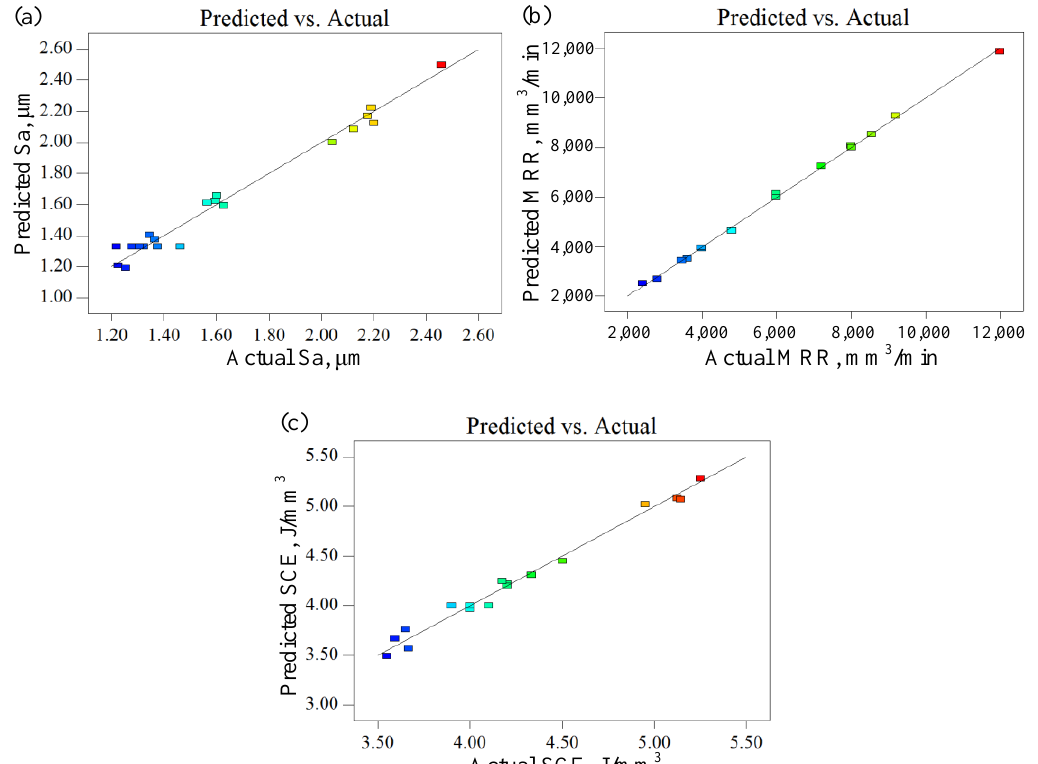
Figure 8. Plots of predicted vs. actual of ( a ) surface roughness; ( b ) material removal rate (MRR); ( c ) ( c ) specific cutting energy specific cutting energy (SCE).